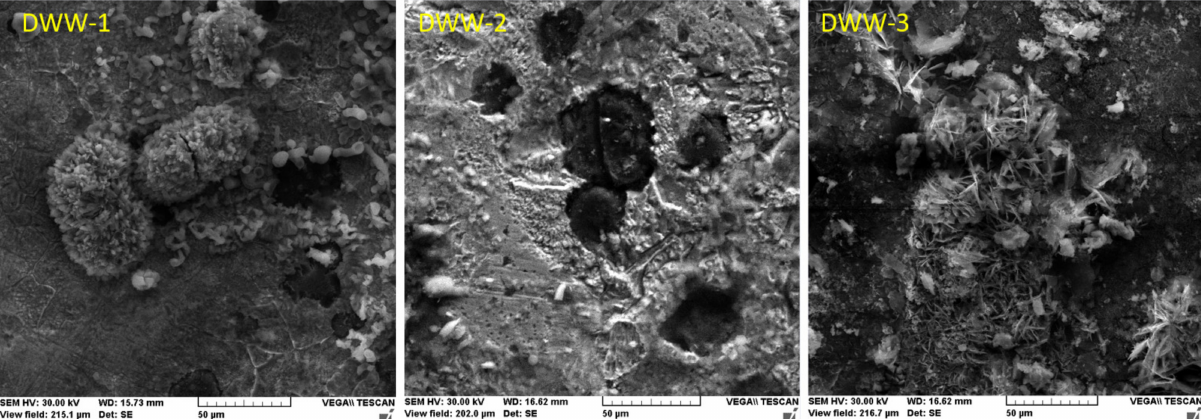
Figure 11. SEM microphotographs for samples immersed for 30 days in artificial domestic